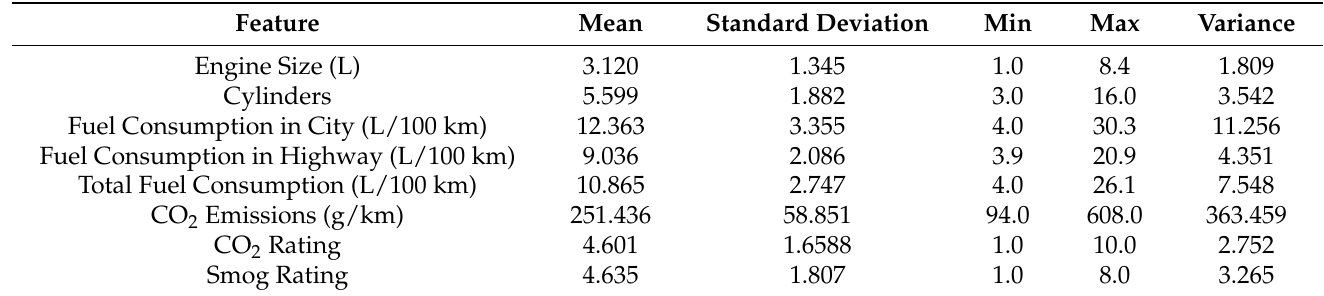
Table 1. Descriptive statistics of numerical columns of the dataset.